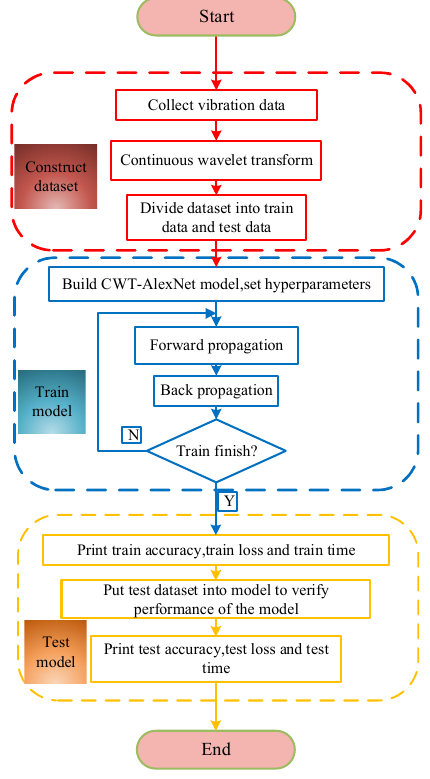
Figure 2. Network training process.